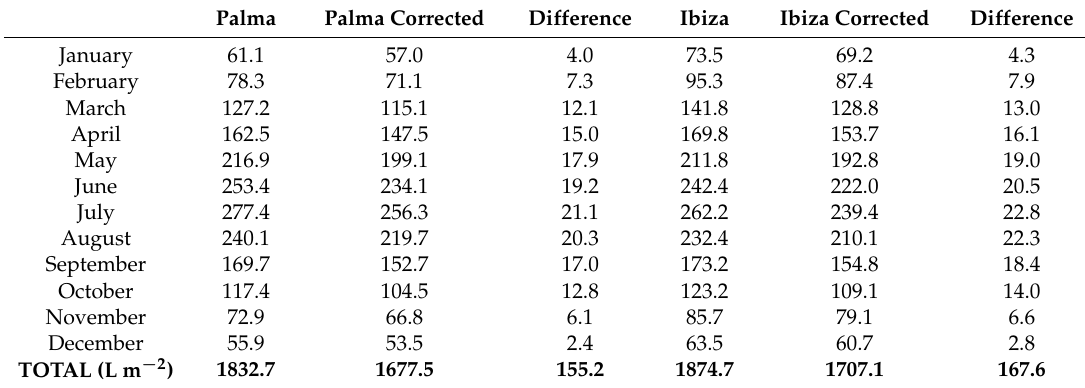
Table 3. Evaporation calculations corrected for decreased radiation received by swimming pools due to shading during some hours of the day. Units: L m − 2 . Palma Palma Corrected